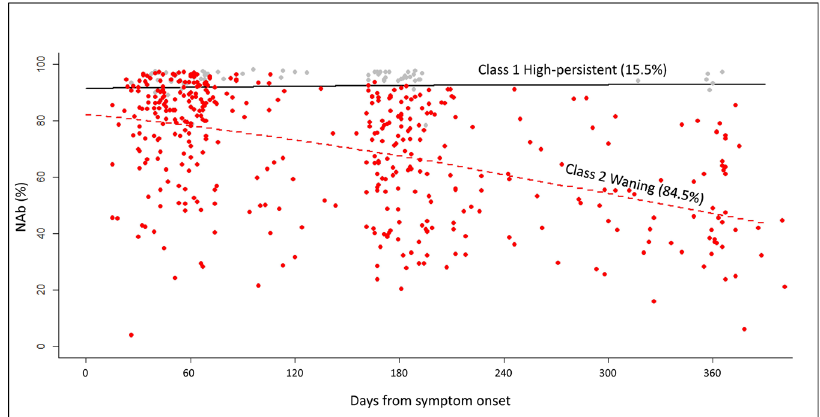
Fig. 3 Class-speci fi c mean predicted trajectory of neutralising antibody (NAb) level by surrogate virus neutralisation test (sVNT), n = 200. Trajectory of neutralising antibody (NAb) level for Class 1 (31 patients) and Class 2